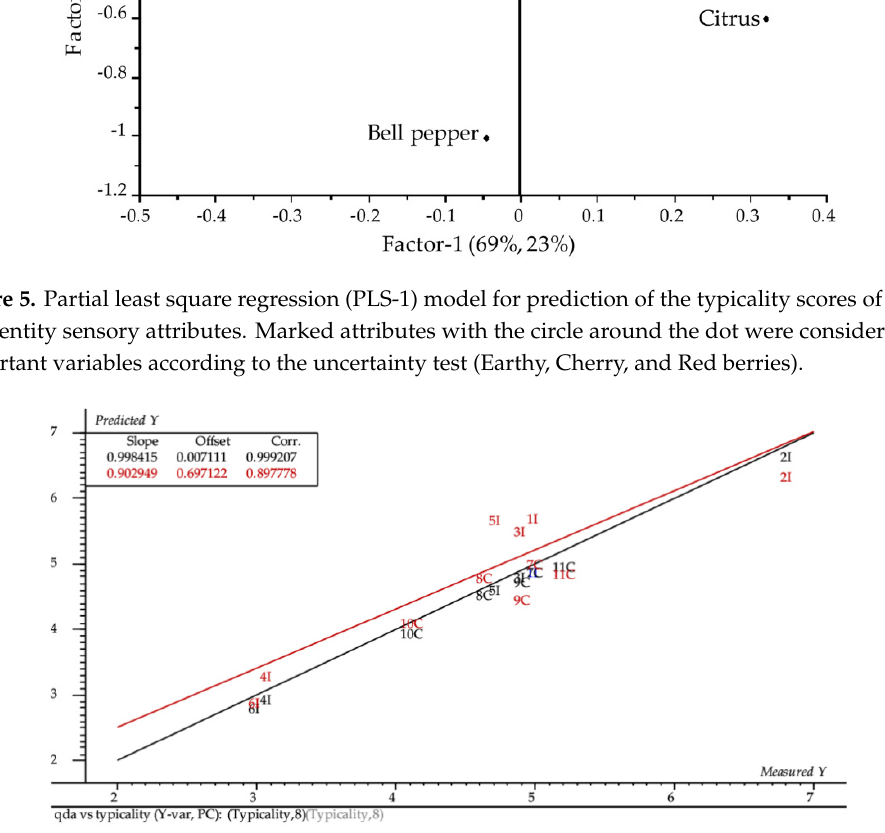
Figure 6. Comparison of predicted wine typicality plotted against the measured value (PLS-1). The black line is the reference model and the red line the predicted model. See Table 1 for wine codes.